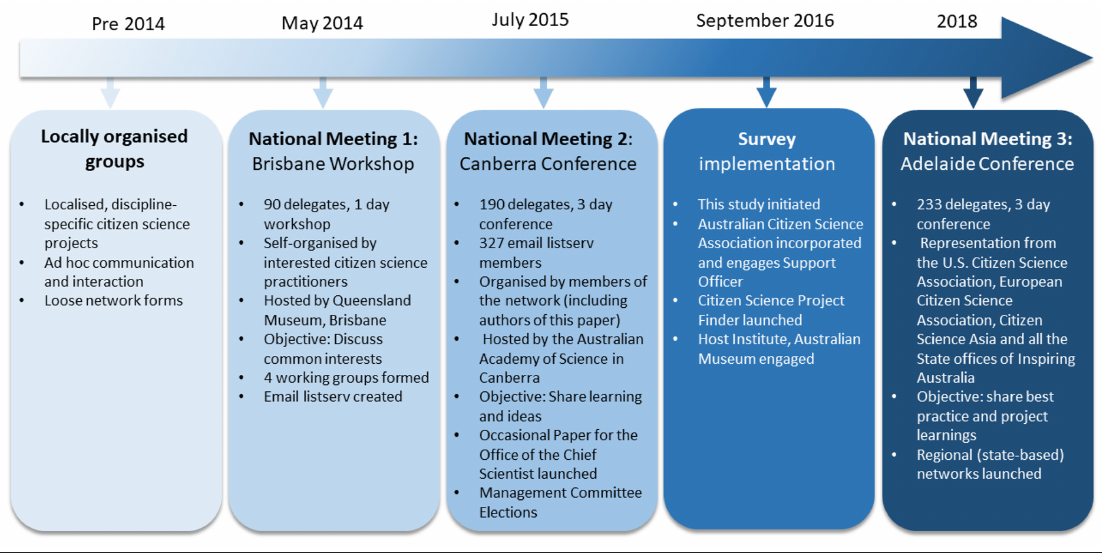
Figure 1 Timeline of events of national citizen science meetings and survey implementation. Created from material provided by Australian Citizen Science Association, https://citizenscience.org.au/